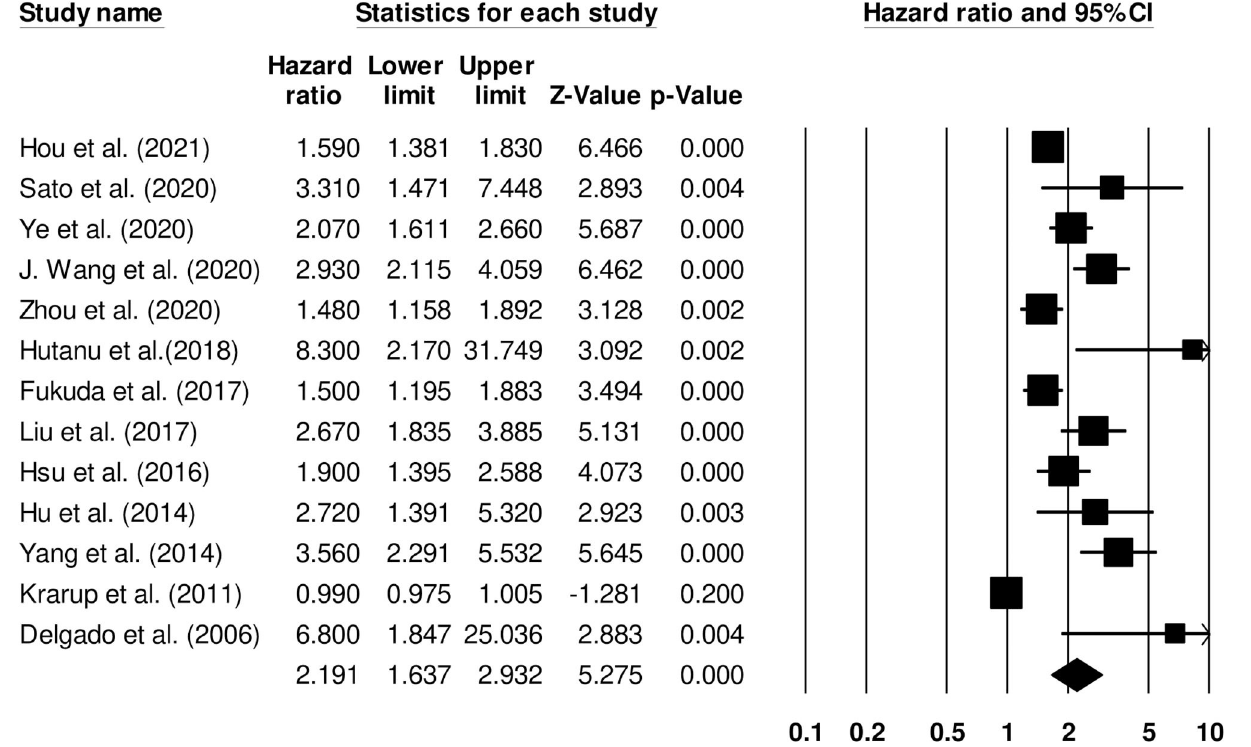
FIGURE 4 | Forest plot for studies evaluating the impact of D-dimer level on post-stroke functional outcomes. Hazard ratios are presented as black boxes while 95% confidence intervals are presented as whiskers. A small hazard ratio represents a lower influence of D-dimer levels on stroke patient functional outcome while a higher hazard ratio represents a higher influence.